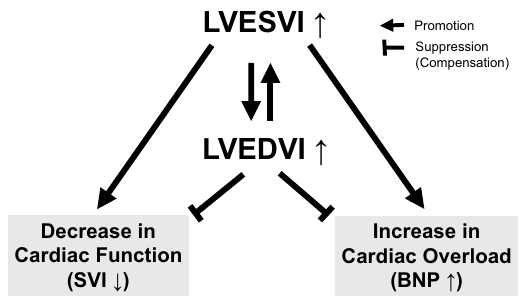
Figure 7. Explanatory drawing of the possible links of the hemodynamic parameters with the plasma B-type natriuretic peptide levels. The promoting and suppressing effects of these parameters on cardiac function and overload are demonstrated. BNP, B-type natriuretic peptide; LVESVI, left ventricular end-systolic volume index; LVEDVI, left ventricular end-diastolic volume index; and SVI, stroke volume